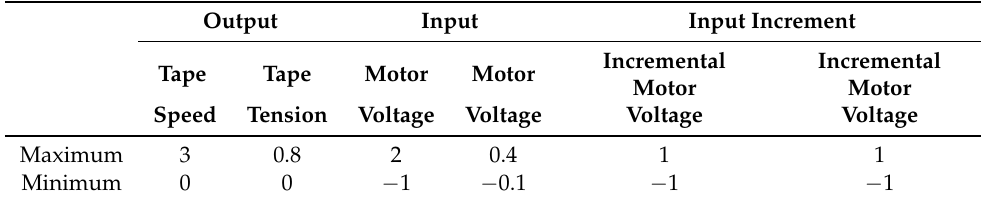
Table 3. Tape transport system constraints.